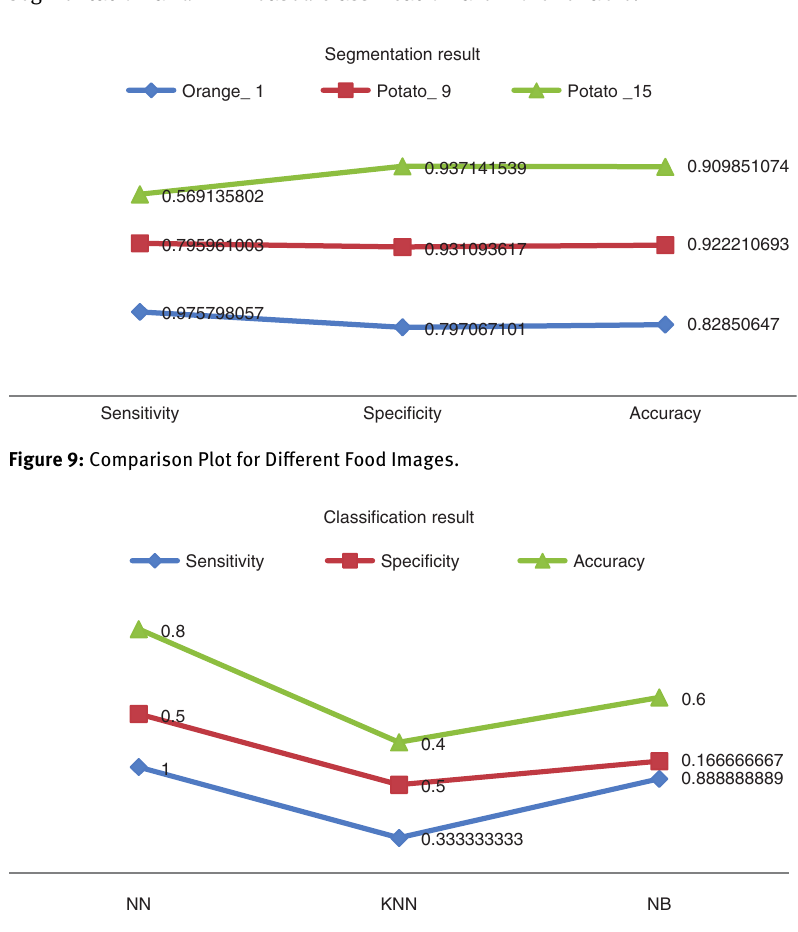
Figure 10: Comparison Plot for Proposed vs. Existing Technique for Different Food